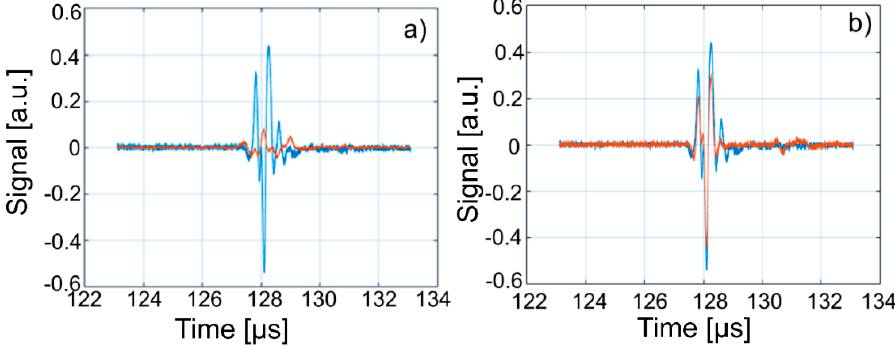
Figure 14. Overlapping of the second echo of Wi (blue) over signals from: WZn ( a ); and Wd ( b ) (orange).